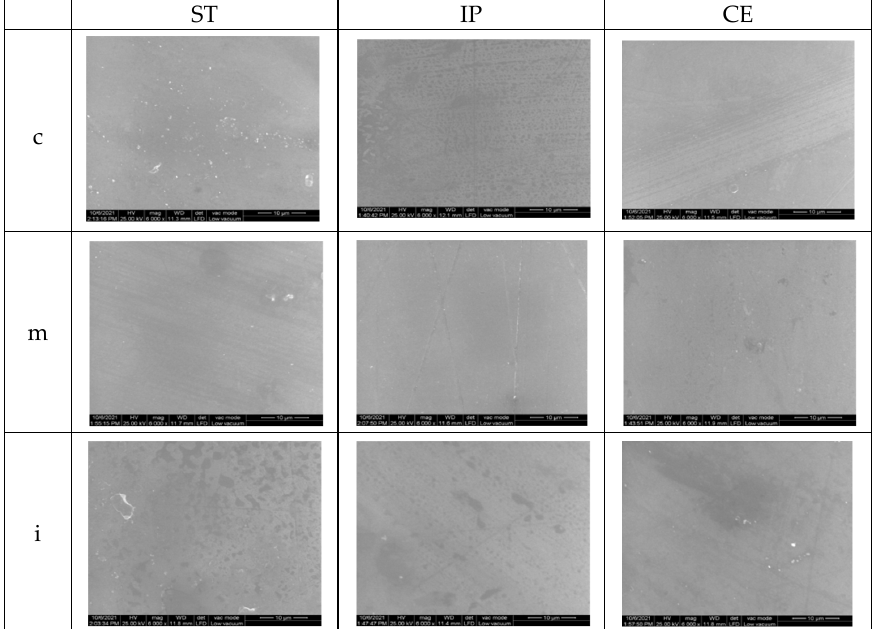
Figure 7. SEM images for glazed samples before aging. ST= STML, IP= IPS e.maxZirCAD CEREC/in Lab MT Multi, CE= CeramillZolidfx ML, c = cervical, m = medium, i = incisal.